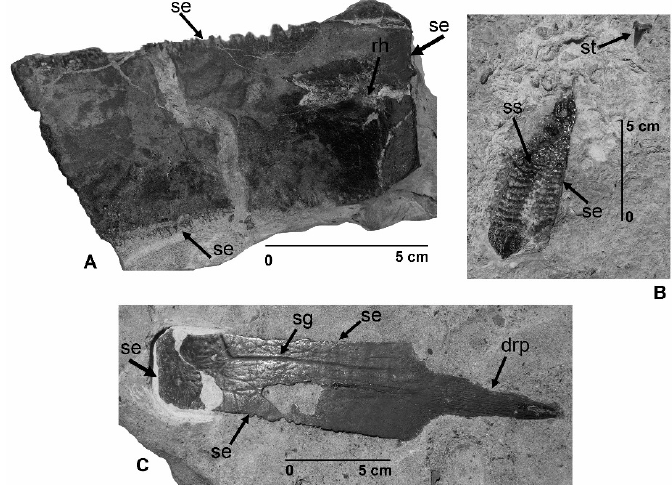
Figure 6. Turtle costals from the basalmost Midway Group lag deposit Hot Spring County, Arkansas.